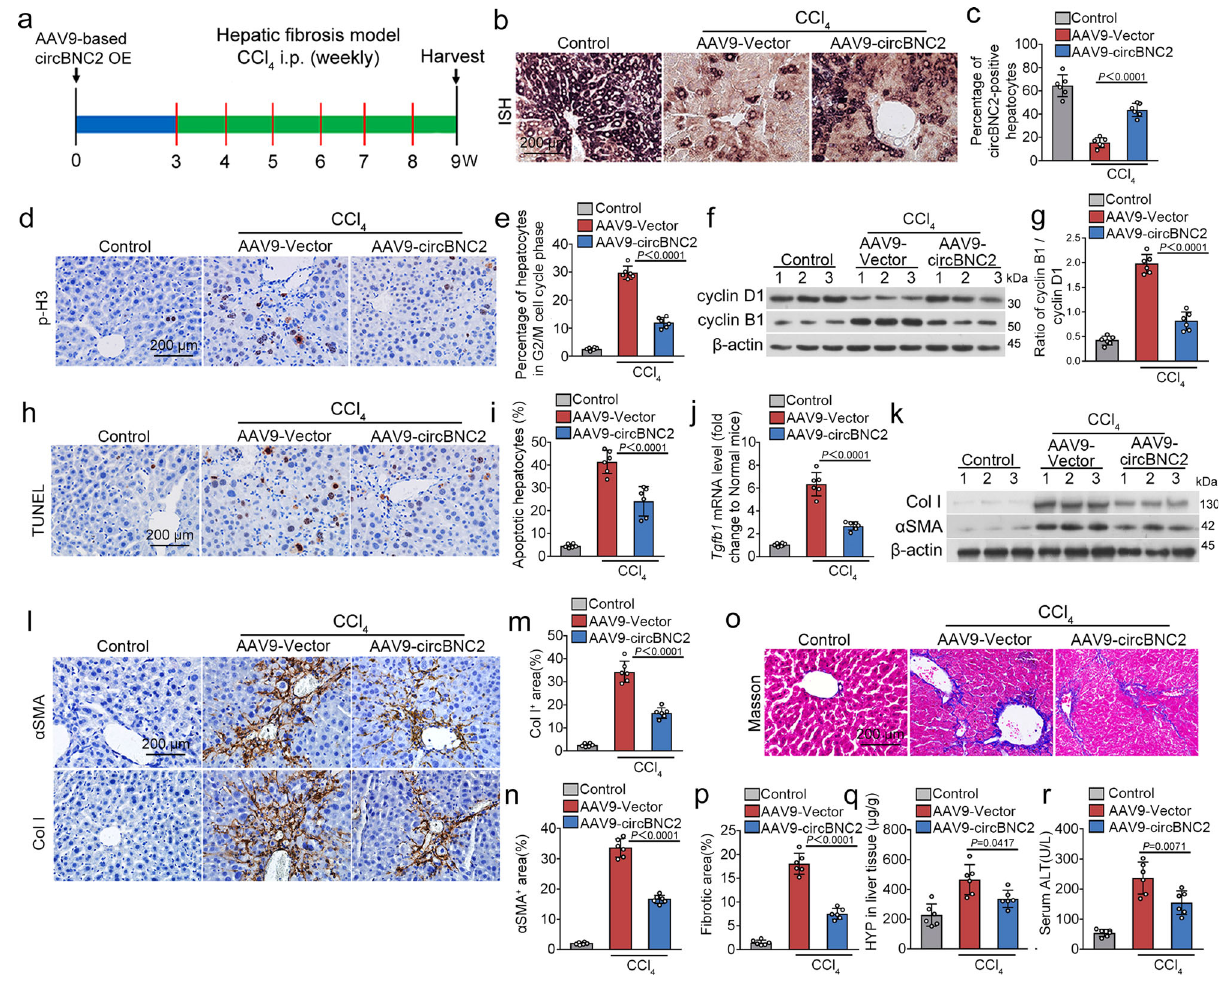
Fig. 6 | Overexpression of circBNC2 inhibits liver fi brosis by attenuating hepatocytesarrestedin G2/M phase.a Mice weretreatedby tail vein injection of either AAV9-circBNC2 or AAV9-Vector 3 weeks before processing hepatic fi brosis model by injecting CCl 4 (once a week for 6 weeks). Mice were euthanized 6 weeks postthe fi rstinjectionofCCl 4 . b , c Representativeimagesofinsituhybridizationof circBNC2 expression in livers from mice injected with AAV9-circBNC2 ( b ) and the quanti fi cation data ( c ). d , e Representative images of Immunohistochemistry of p-H3 in liver sections from mice treated with AAV9-circBNC2 and CCl 4 ( d ),and the quanti fi cationdata( e ). f , g WesternblotsshowingexpressionofcyclinB1andcyclin D1inmicetreatedwithAAV9-circBNC2andCCl 4 ( f ),andthequanti fi cationdata( g ). h , i RepresentativeimagesofTUNELstainingofapoptoticcellsinthesectionsfrom CCl 4 -treatedmiceoverexpressedwithcircBNC2( h ),andthequanti fi cationdata( i ). j qRT-PCR showing the expression of Tgfb1 in livers from CCl 4 -treated and